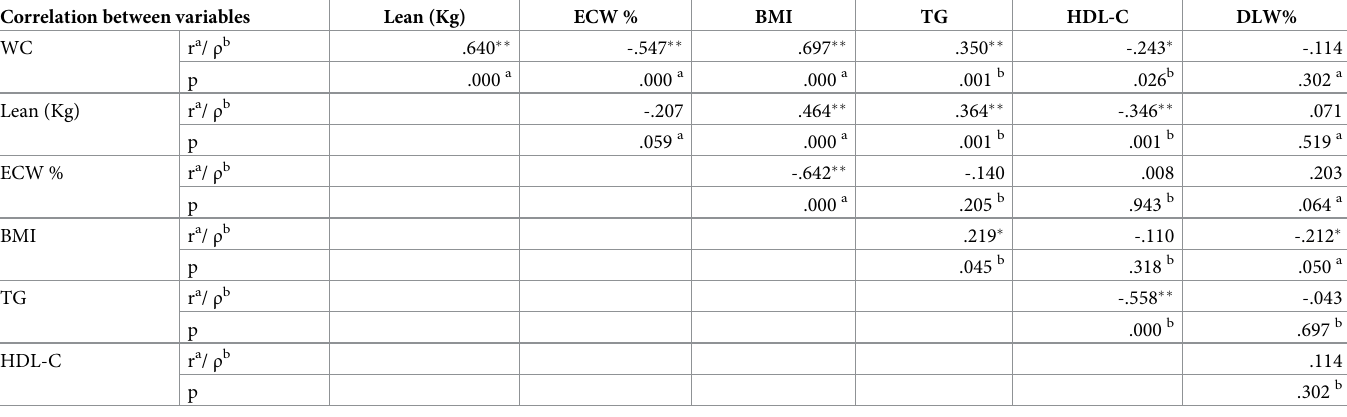
Table 3. Correlation between anthropometric measurements, body composition parameters and lipid profile in control group (n = 84). Correlation between variables